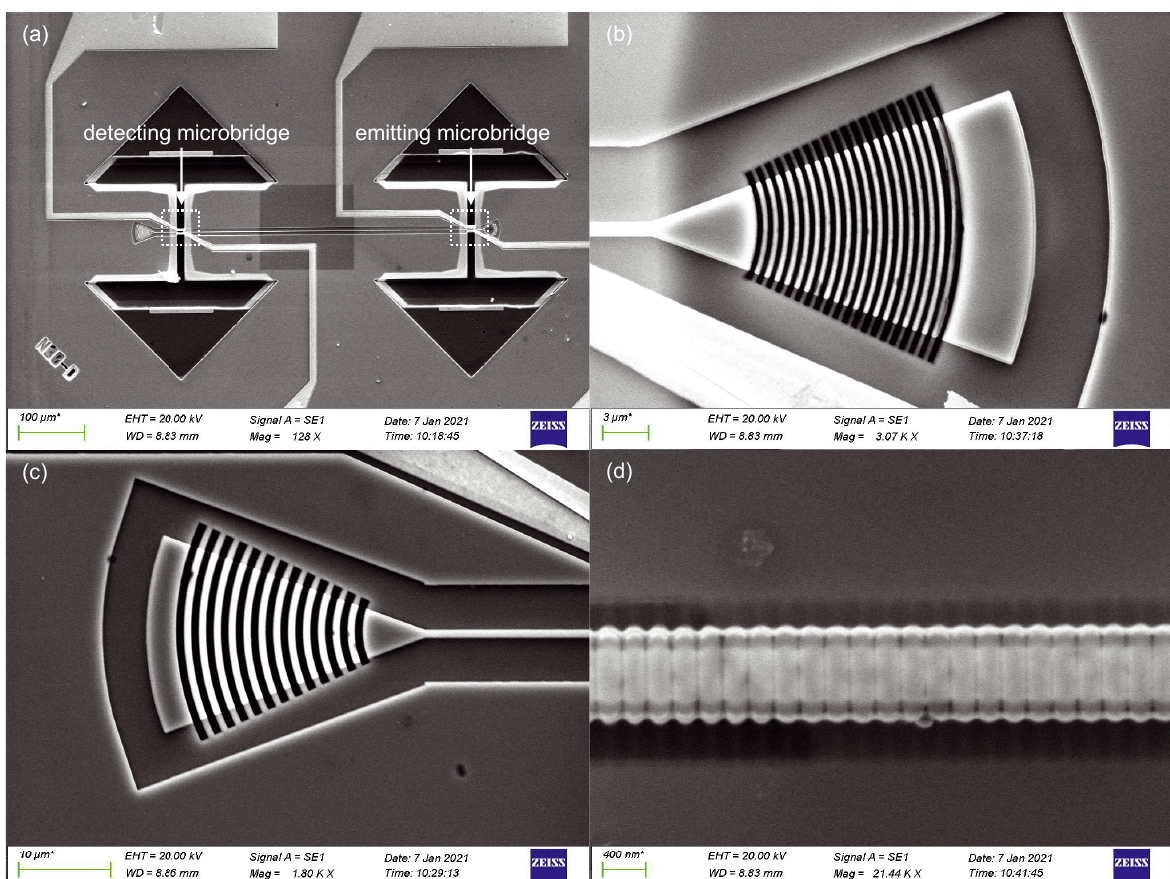
Figure 5: Scanning electron microscope (SEM) images of the fabricated device. (a)Overallviewoftheemitting-detectingconfigurationwithbothofthemicrobridgessuspended.(b)FocusingDBRgrating.(c)Gratingcoupler. (d) Ridge waveguide with surface DBR